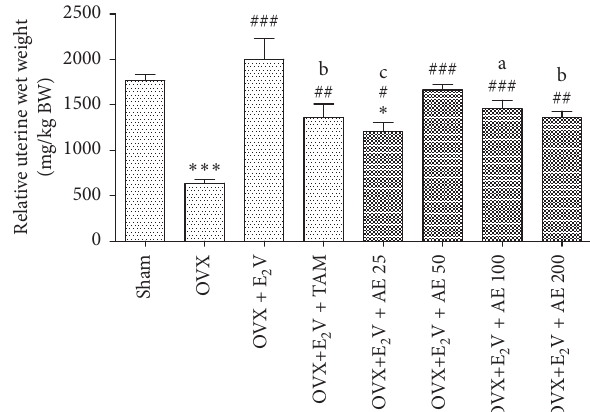
Figure 2: Effects of treatments on the relative uterine wet weight. SHAM: sham-operated animals; OVX: ovariectomized animals; E 2 V: estradiol valerate; TAM: tamoxifen; AE: aqueous extract of D. edulis leaves. Data are presented as mean ± S.E.M. ( n � 6). ∗ p < 0 . 05 and ∗∗∗ p < 0 . 001 compared with SHAM; # p < 0 . 05, ## p < 0 . 01, and ### p < 0 . 001 compared with OVX; and a p < 0 . 05, b p < 0 . 01, and c p < 0 . 001 compared with OVX+E 2